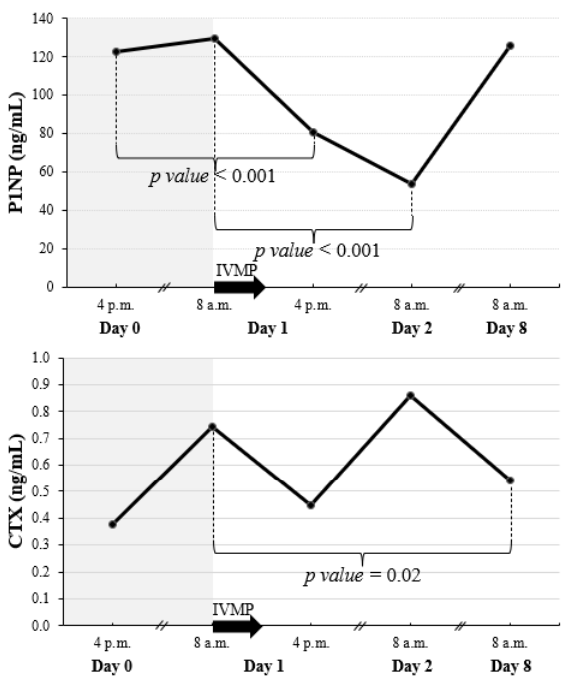
Figure 2. Early changes of P1NP and CTX after a single pulse of 0.5 g IVMP. The black arrow repre- sents IVMP pulse of 0.5 g. When significant difference between consecutive values was found, p value is given. CTX, C-terminal telopeptide of type I collagen; IVMP, intravenous methylprednisolone; P1NP, amino-terminal propeptide of type I procollagen.